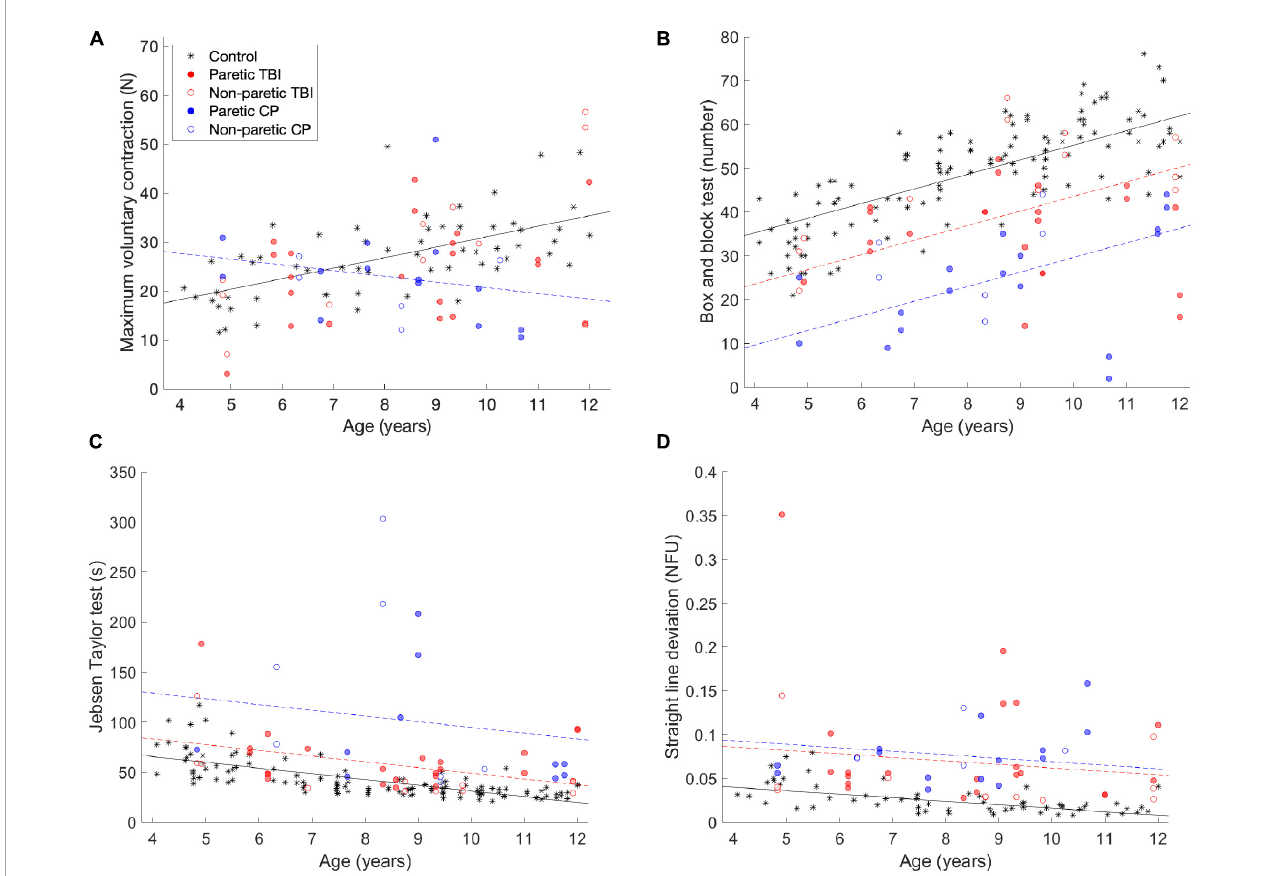
FIGURE1 Comparisons of the (A) maximum voluntary strength (MVC) data, (B) box and block test (C) Jebsen-Taylor test of hand function and (D) task performance—straight line deviation. The data from this experiment is compared to data from a previous study (the black stars). The black line is the predicted data for the control group, the dashed red line is the predicted data for the TBI group, and the dashed red line is the predicted data for the CP group, according to the tested models. The lines are only drawn when the differences between the groups was significant.